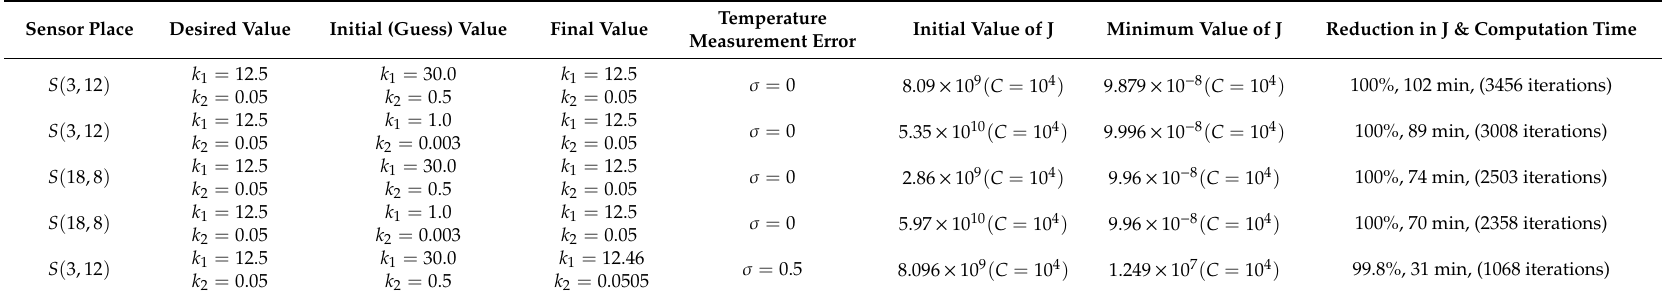
Table 3. A summary of results for the estimation of the temperature-dependent thermal conductivity components k 1 and k 2 ( k T = k 1 + k 2 T